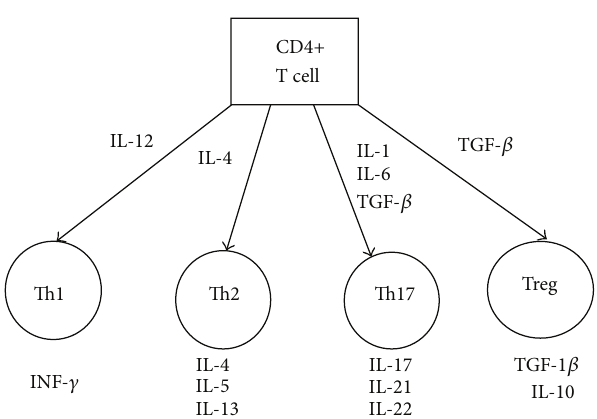
Figure 1: T CD4+ cell